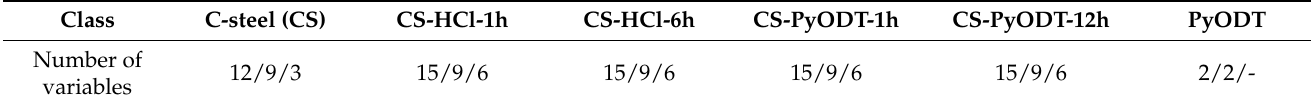
Table 4. Machine learning data, number of Raman spectra–total/training/testing used for each